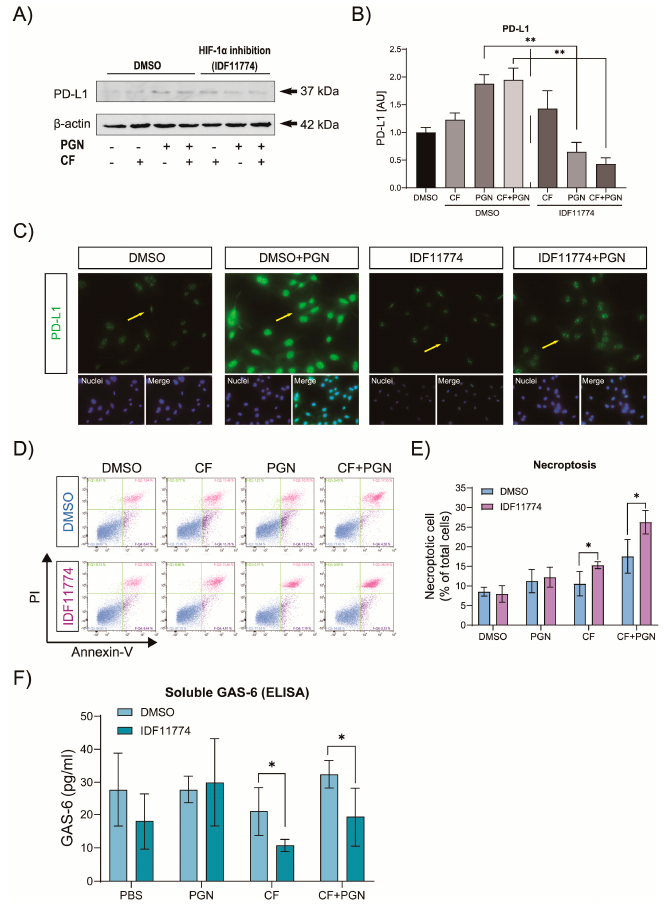
Figure 4. P. gingivalis PGN-induced PD-L1 expression depends on HIF-1 α signaling in OCCM-30 cells under compressive force. OCCM-30 cells were preincubated with different concentrations of the HIF-1